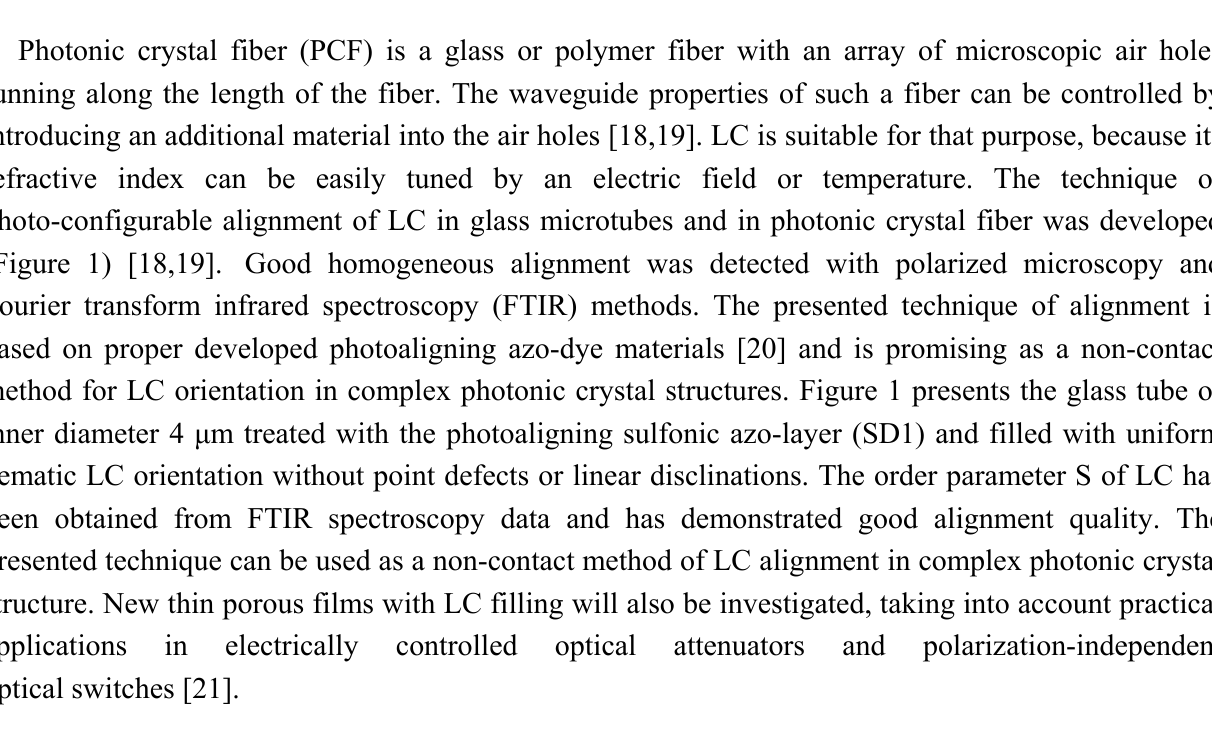
Figure 1. High-quality liquid crystal (LC) alignment in microtubes (photonic crystal holes)